Question: Looking at the figure, what chart type is it?
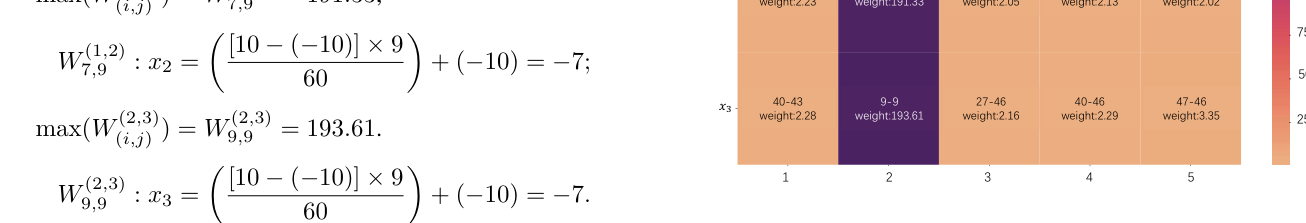
Answer: heatmap